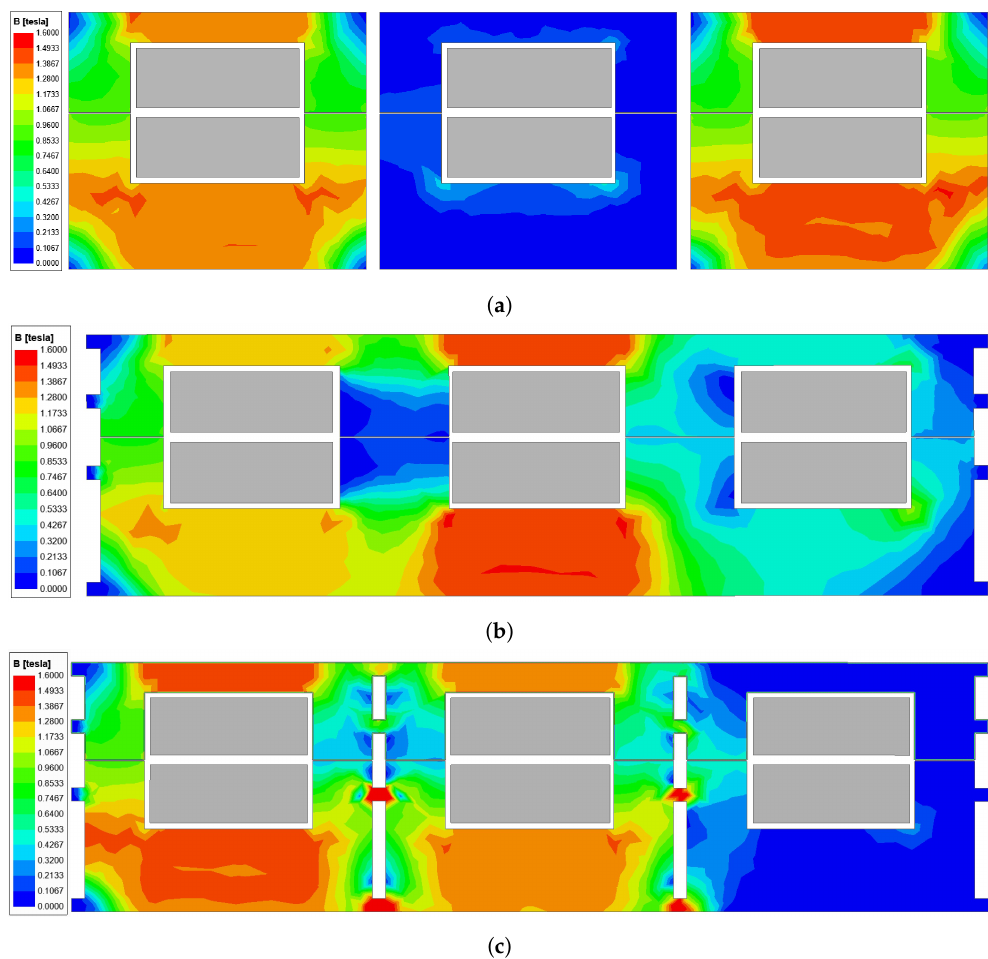
Figure 7. Open circuit flux density plot of the radially stacked three-phase rotary transformer with filler laminations with the core: ( a ) type I, ( b ) type II and ( c ) type